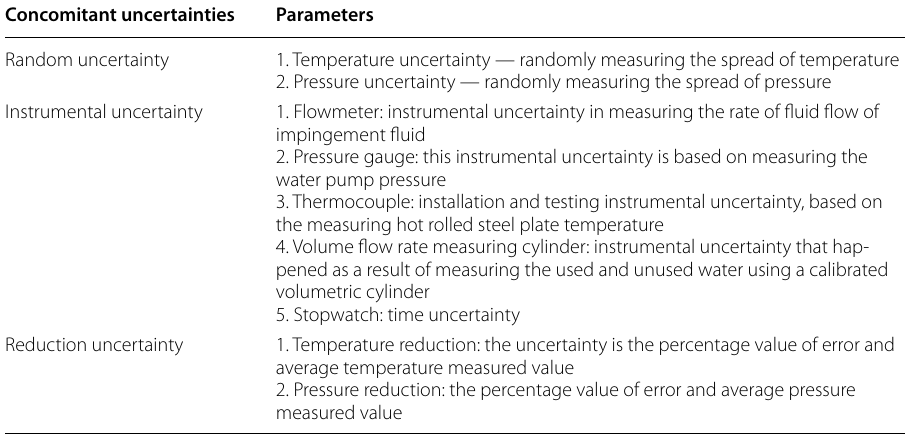
Table 9 showed the heat fluxes at D 10 mm and 40 mm, highest at the top where the = convective heat transfer coefficient value is more. Heat flux showed a 66.4% difference for D 10 mm and 75.2 for D 40 mm for W-JIC and A-JIC, respectively. Furthermore, = = heat fluxes decreased linearly from top to bottom, showing an increase in convective heat transfer coefficient with corresponding increasing impingement gap H.